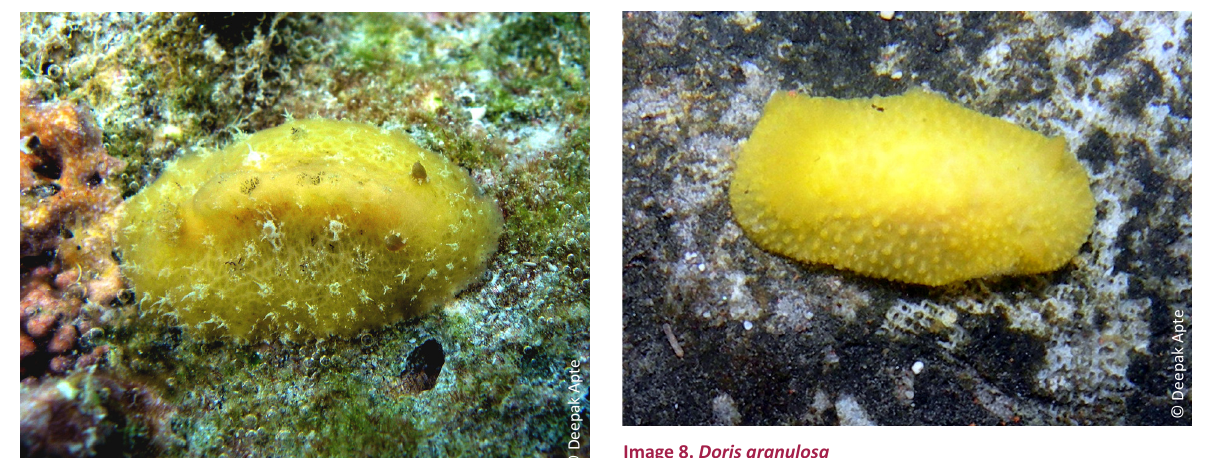
Image 8. Doris granulosa